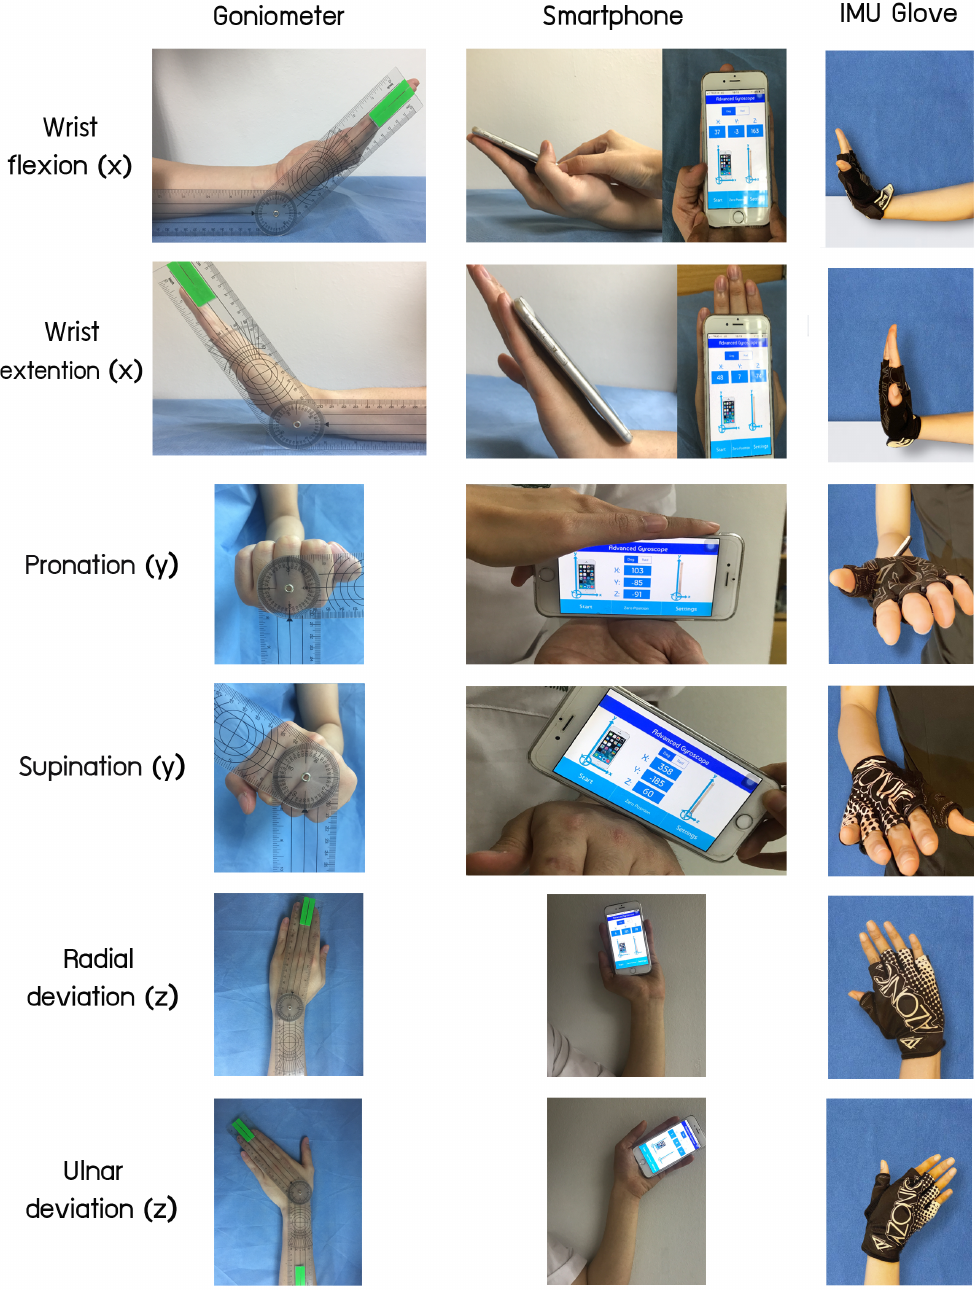
Figure 1. The measurements of wrist range of motion using a standard goniometer, smartphone, and the proposed inertial measurement unit glove for wrist flexion (x), wrist extension (x), pronation (y), supination (y), radial deviation (z), and ulnar deviation (z). A goniometer was placed at the ulnar styloid next to the little finger and set the initial state as the zero-degree position for wrist flexion and extension